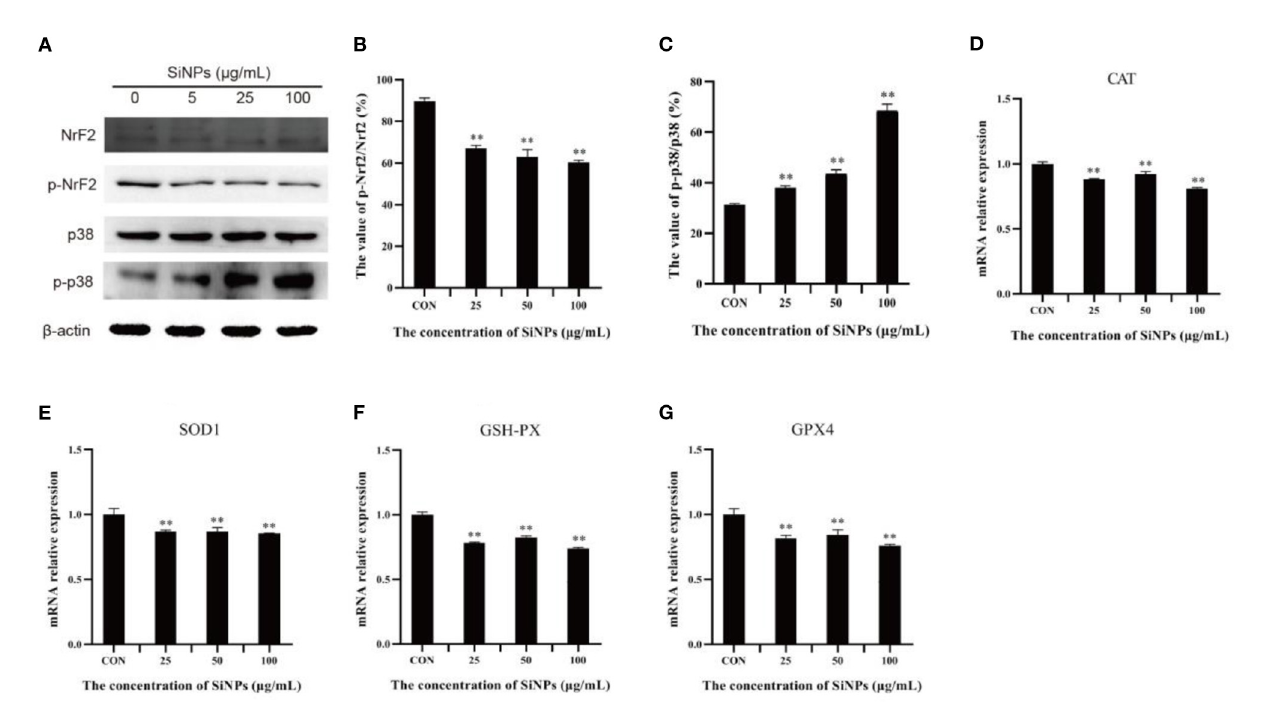
FIGURE5 The phosphorylation of p38 and Nrf2 protiens and mRNA expressions of downstream anti-oxidative enzymes. (A) the protein bands of NrF2, p-NrF2, p38, and p-p38. (B) The relative gray values of p-NrF2 to NrF2. (C) The relative gray values of p-p38 to p38. (D) The relative mRNA expression of CAT. (E) The relative mRNA expression of SOD1. (F) The relative mRNA expression of GSH-PX. (G) The relative mRNA expression of GPX4. [** p < 0.01, compared with the con, n =